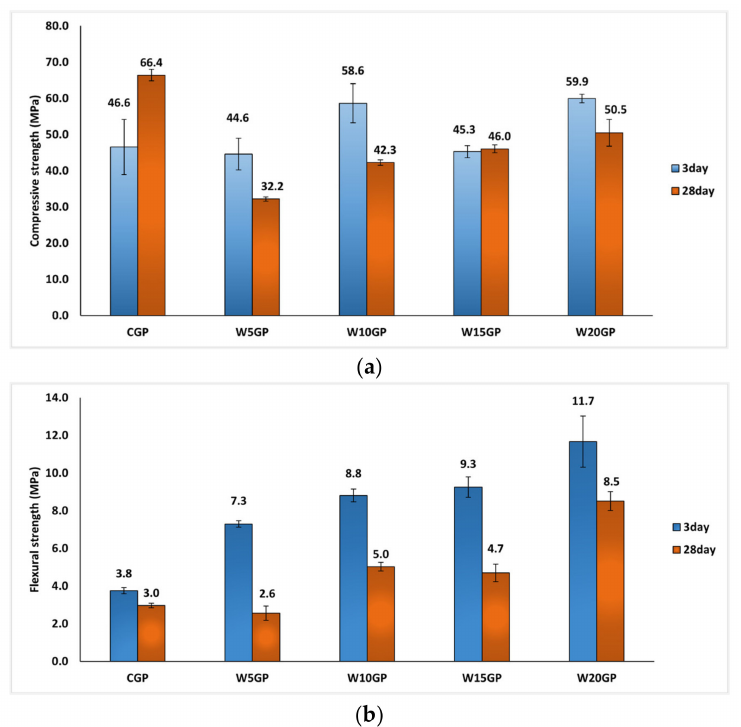
Figure 4. ( a ) Compressive and ( b ) flexural strengths of a sample at 8 M NaOH, SS/SH = 1.00 (heat curing temperature of 60 ◦